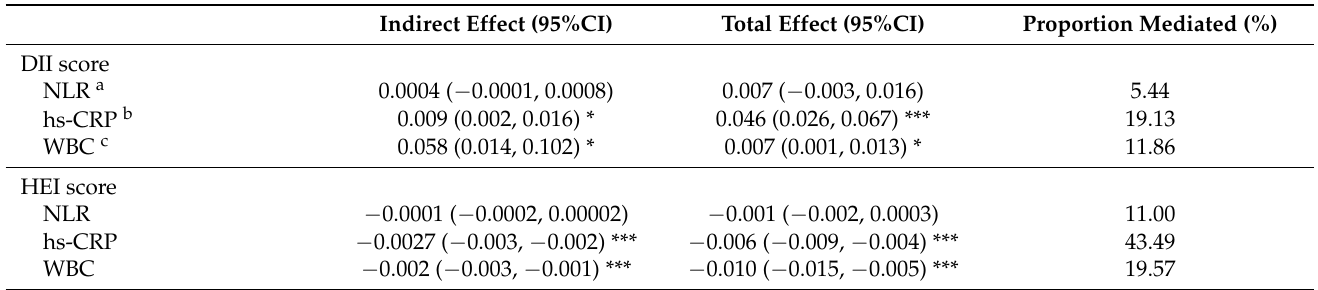
Table 5. The weighted mediating general obesity on the association between dietary score and inflammation